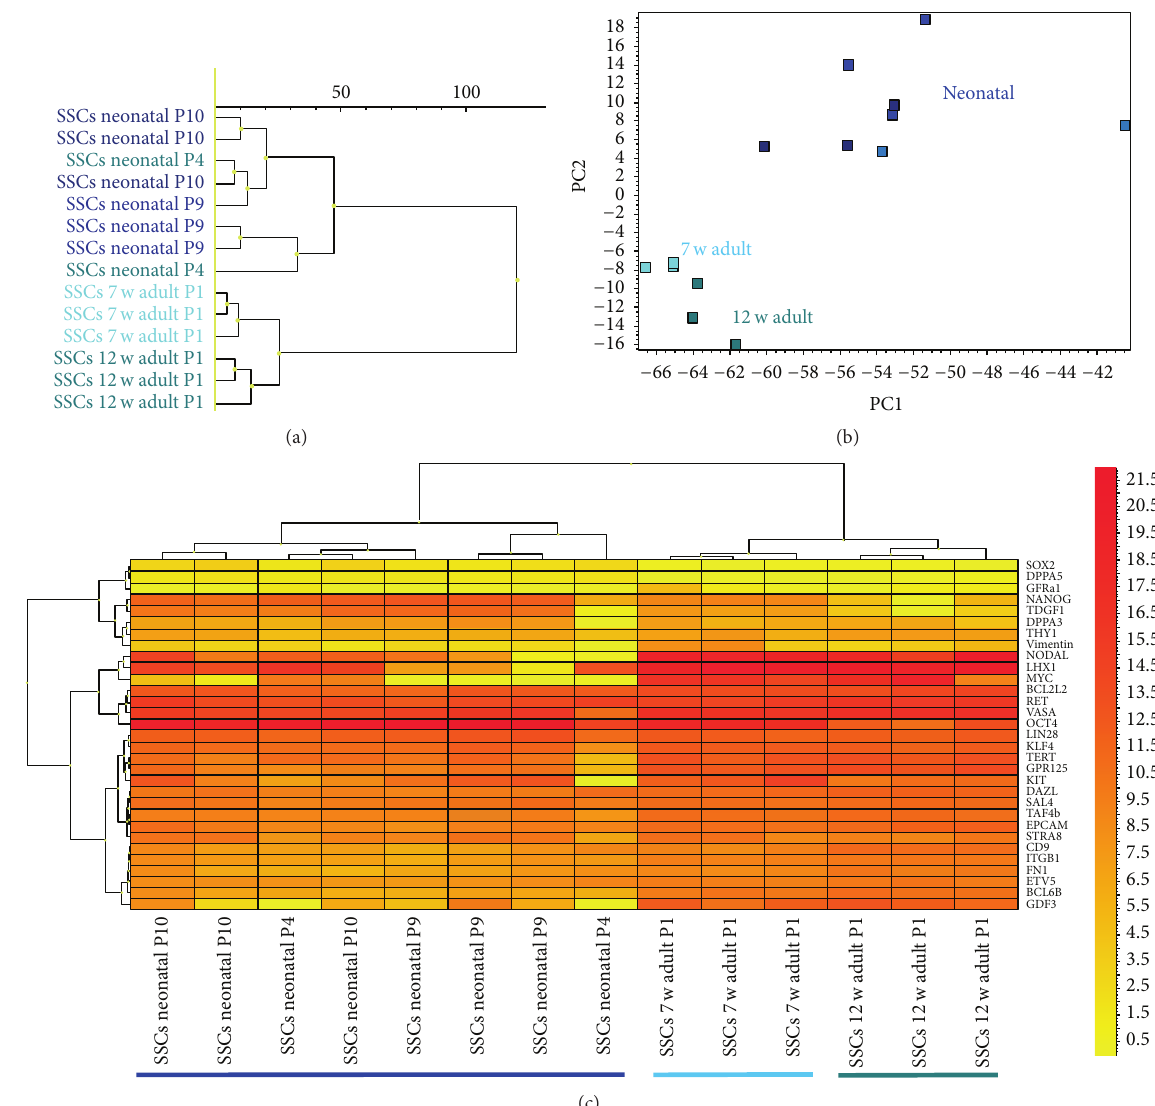
Figure 2: Different gene expression profiles of neonatal and adult SSCs with germ cell-enriched and pluripotency associated genes. Adult SSCs were obtained from 7- and 12-week-old mice. (a) Dendrogram and (b) PCA demonstrate that neonate and adult SSCs are distinct and localize in separated trees in the dendrogram or areas in the PCA. (c) Heat map shows array of pluripotency and germ cell associated genes with a cluster of different populations of neonatal SSCs (coloured dark blue), while adult SSCs cluster from 7- and 12-week-old mice in a separate tree (coloured light blue and